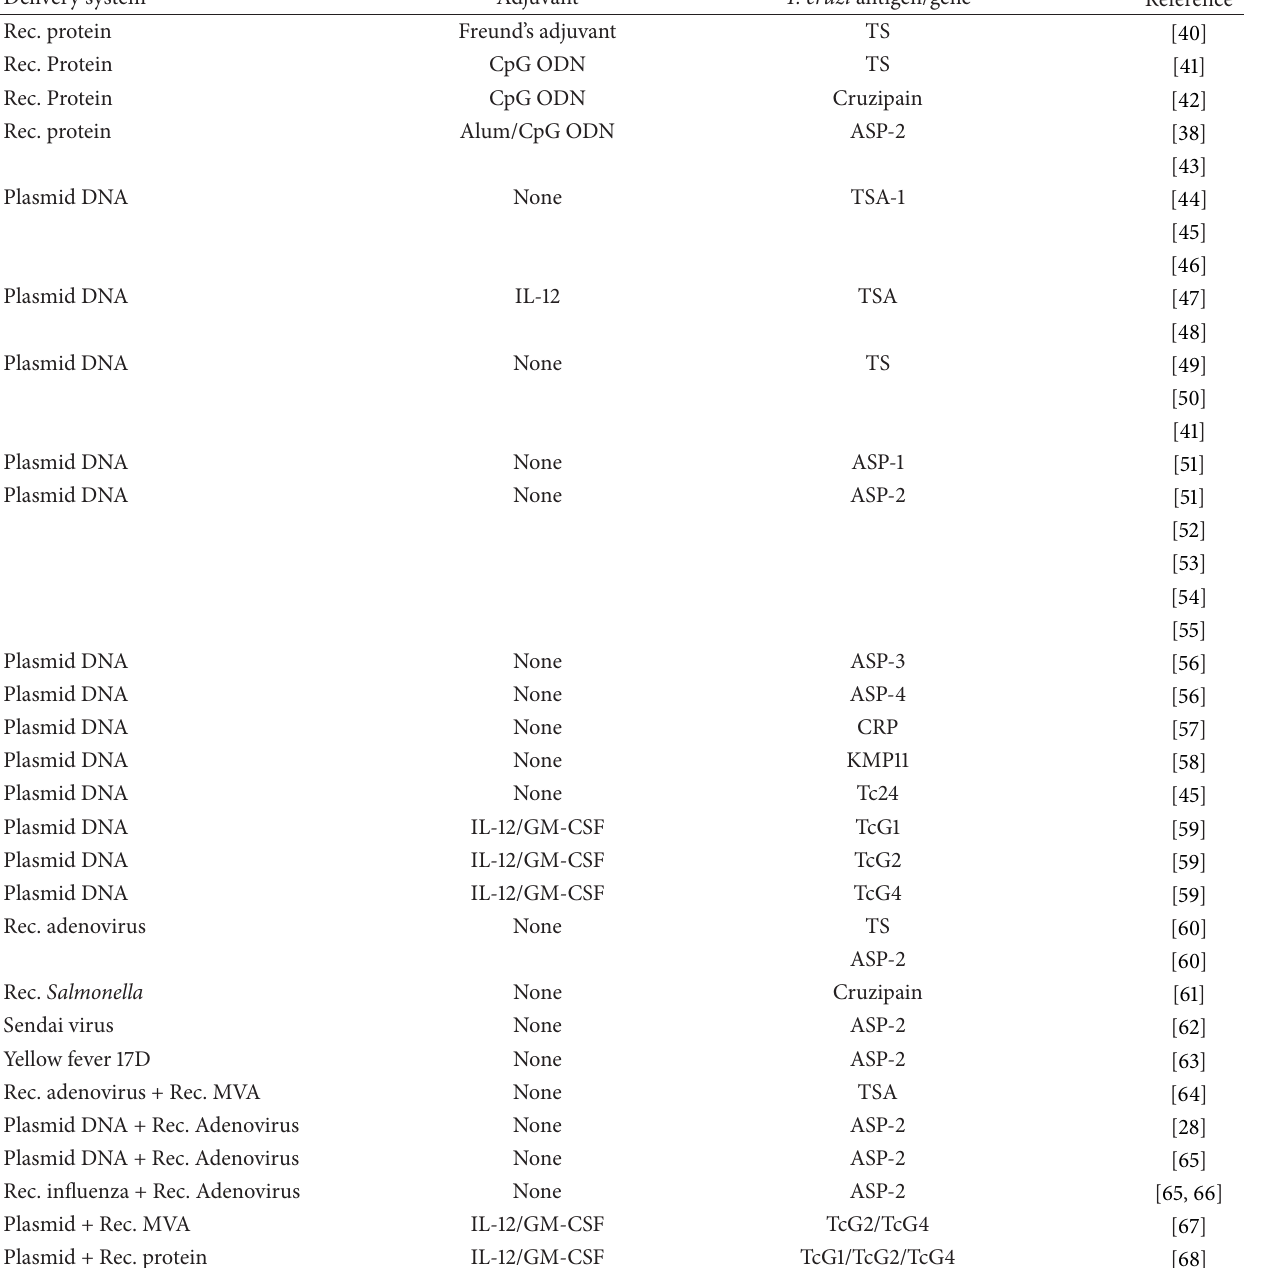
Table 2: Summary of the different antigen delivery systems used for the induction of CD8 + T cells against experimental T. cruzi